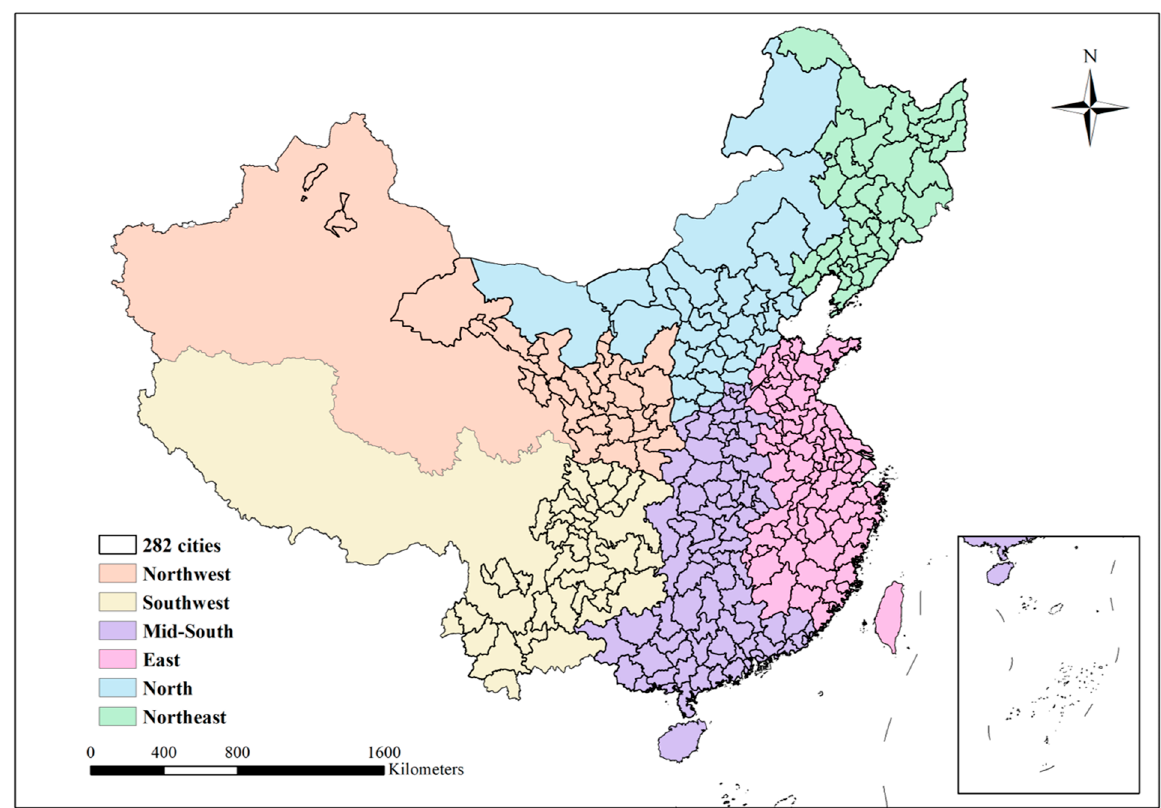
Figure 1. Distribution of 282 cities in six regions in China.